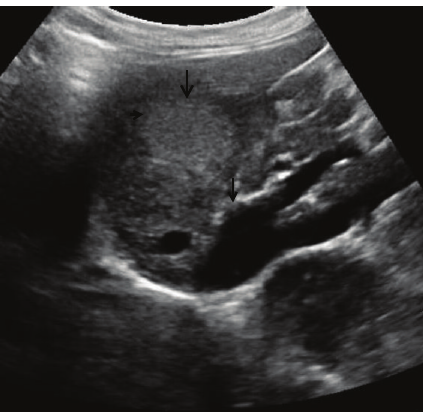
Figure 3: A 12-year-old female with complaints of vague upper abdominal discomfort. A well-defined hyperechoic liver lesion (arrow) with peripheral hypoechoic rim (short arrow) is seen. Thickarrowheadindicatesabnormalcommunicationbetweenmain portal vein and inferior vena cava.